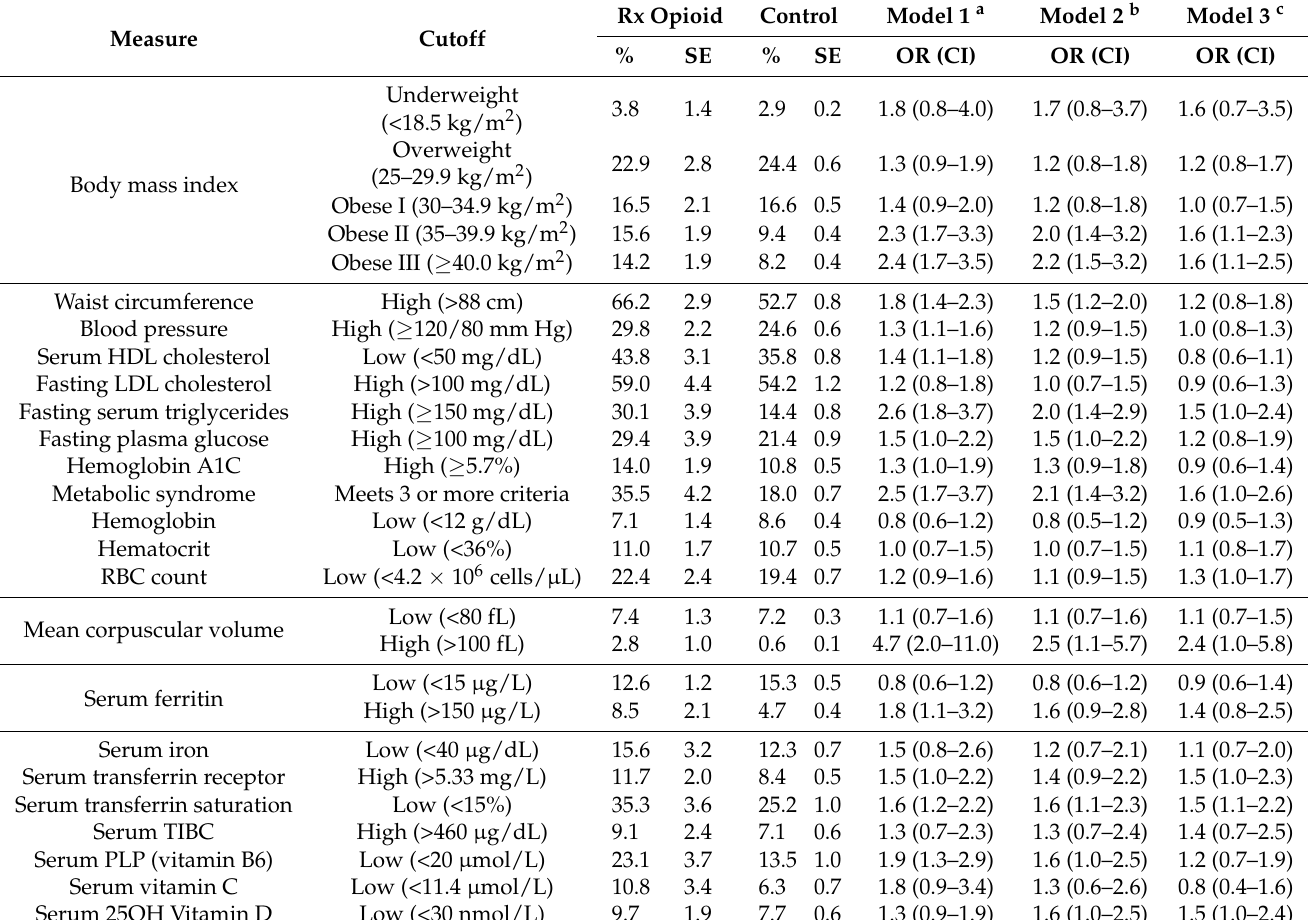
Table 3. Health and nutrition status using clinically relevant cutoffs among women of reproductive- age by prescription opioid use